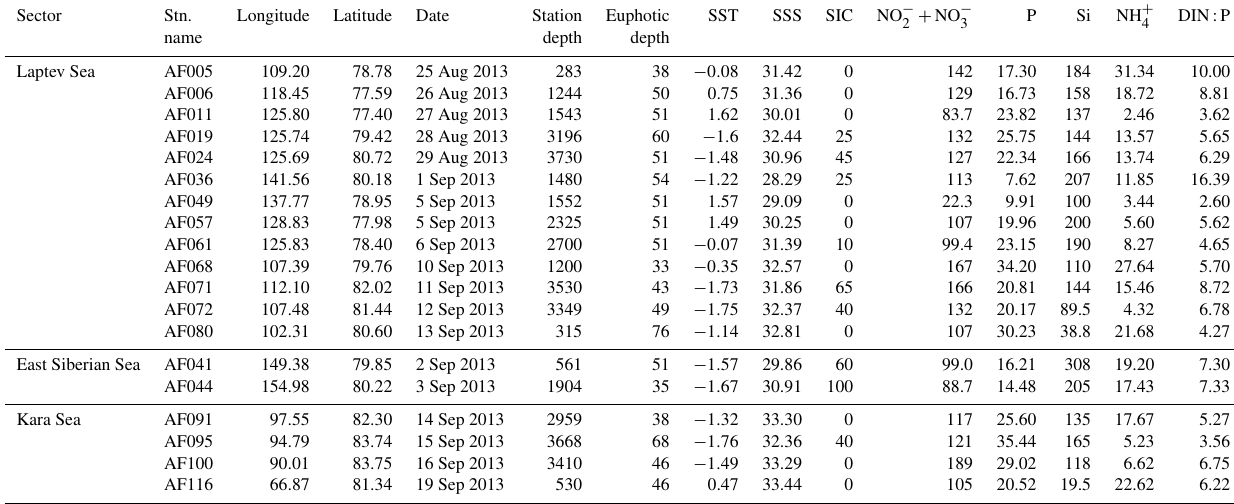
Table 1. The physical and chemical properties of the sampling locations in the East Siberian Sea and the Laptev Sea, where station depth, euphotic depth, sea surface temperature (SST), and sea ice cover (SIC) are represented in m, m, ◦ C, and %, respectively. The sea surface salinity (SSS) is represented in practical salinity unit (PSU). The nutrient concentrations (NO − NH + ) are given as the depth-integrated values in the euphotic zones, with a unit of mmolm − 2 . The DIN:P is the nutrient stoichiometry 4 calculated from the available nutrient